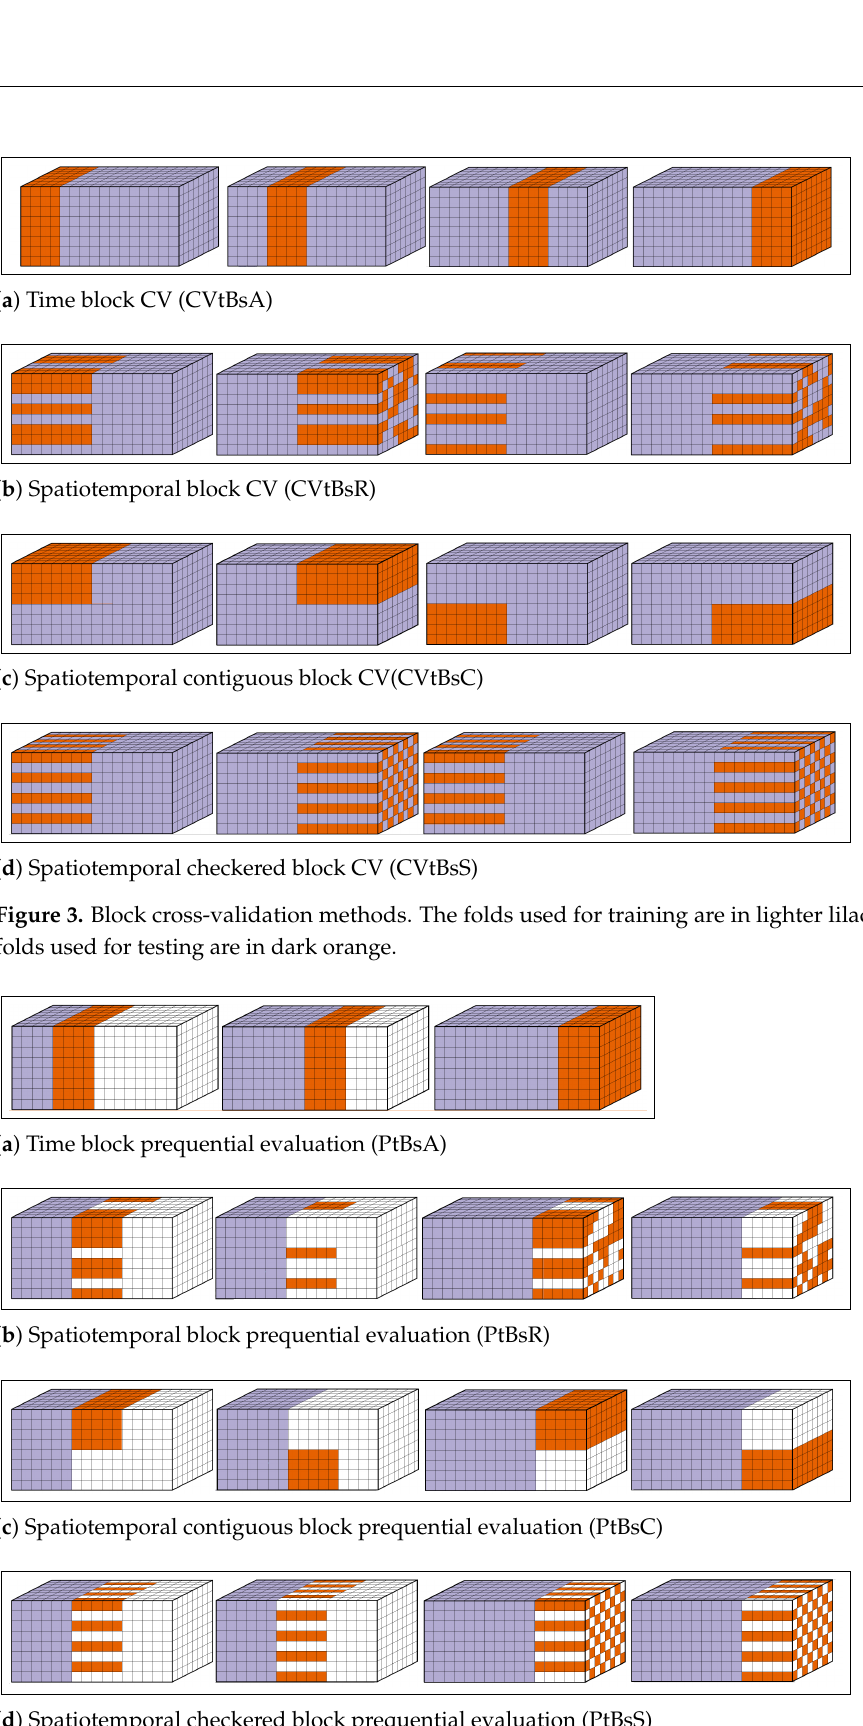
Figure 4. Prequential evaluation methods with growing window. Blocks of data used for training in lighter lilac; blocks of data used for testing in dark